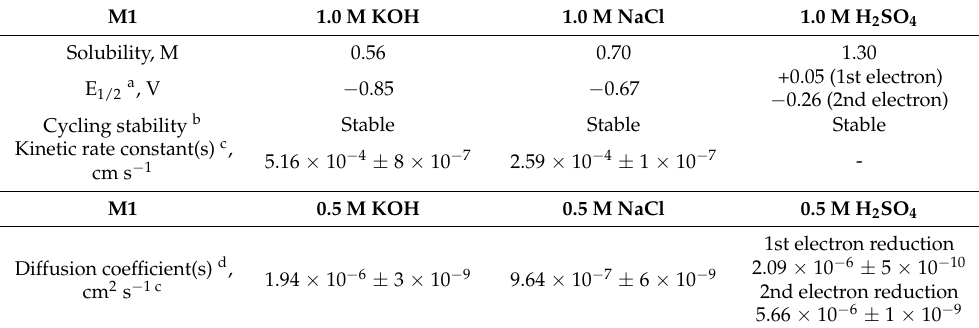
Figure 1. ( a ) Synthesis of the 3,3 (cid:48) -(phenazine-2,3-diylbis(oxy))bis( N , N , N -trimethylpropan-1-aminium) ( M1 ). ( b ) Photograph of concentrated solutions of M1 in pure water, 1.0 M NaCl, 1.0 M H 2 SO 4 , and 1.0 M KOH solutions. ( c ) NMR spectrum of M1 in DMSO-d 6 (* marked peak at 4.06 ppm appeared due to proton–deuterium exchange at DMSO-HDO-D 2 O system). Table 1. The solubilities, redox potentials, stability under CV tests, diffusion coefficients, and kinetic parameters for M1 compound in different water-based